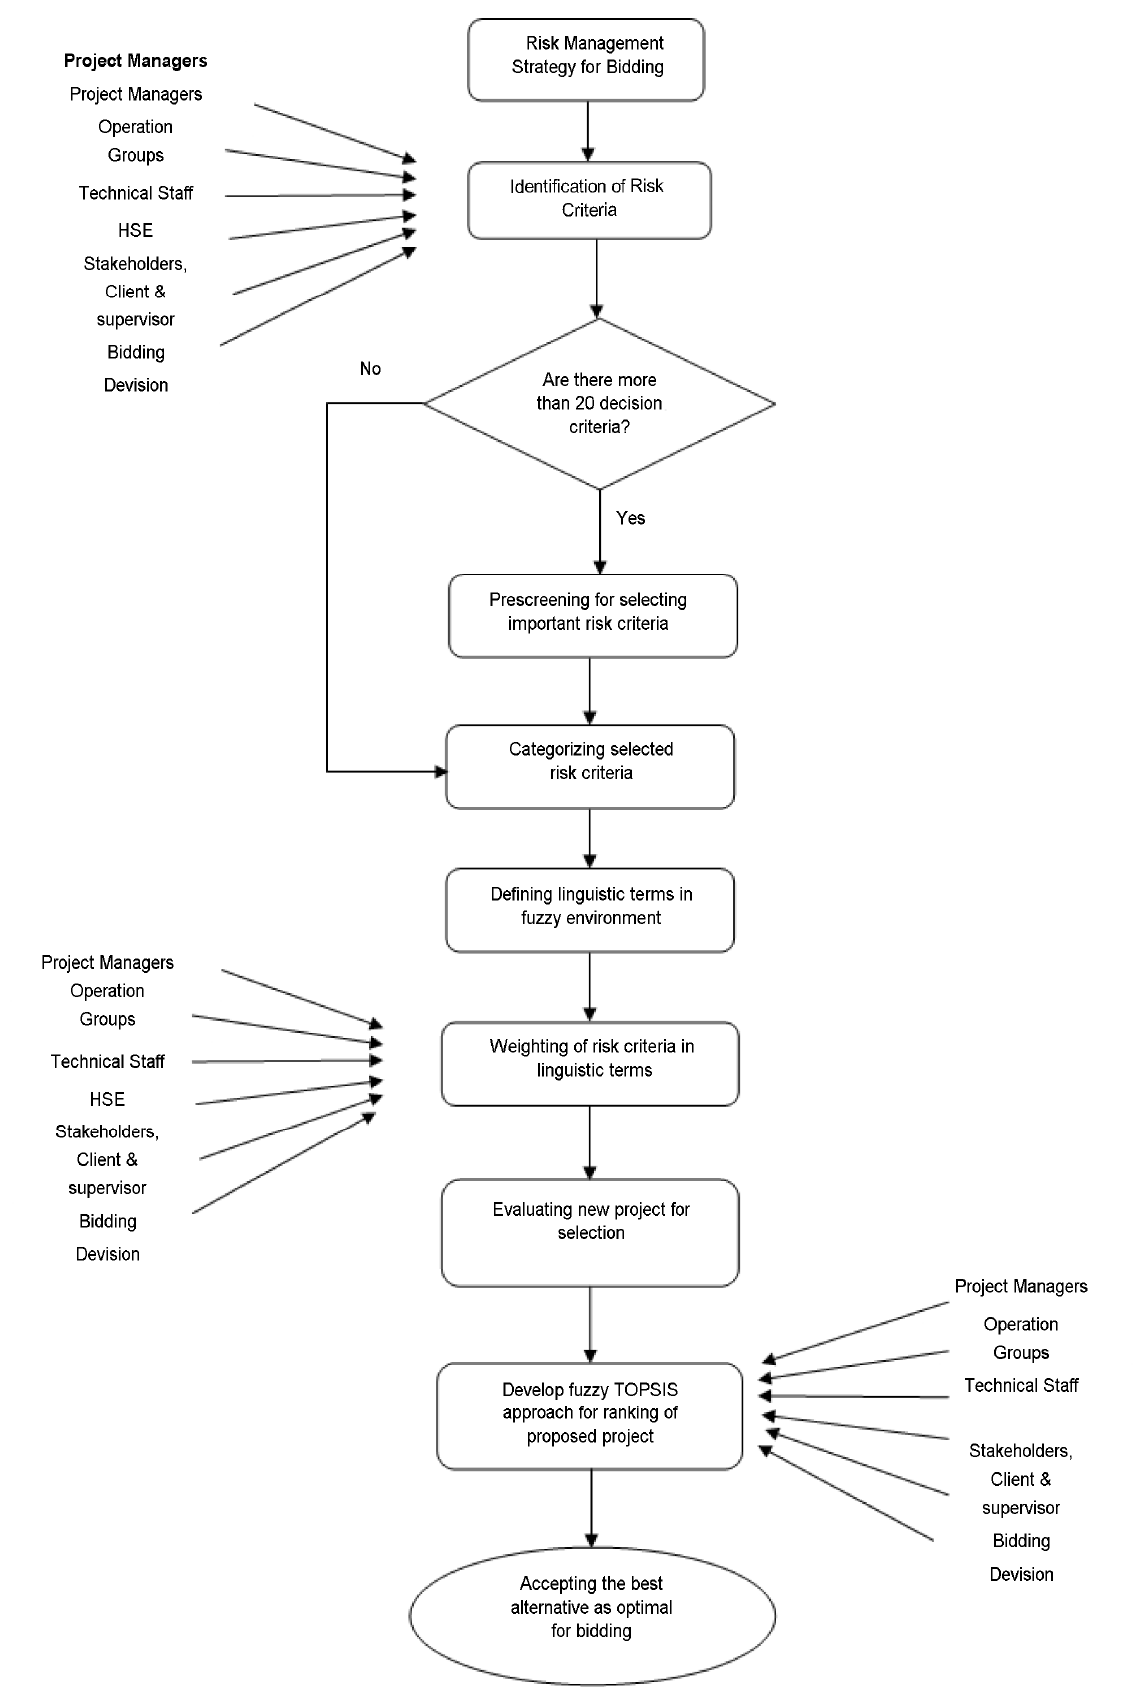
Fig. 2. Proposed methodology